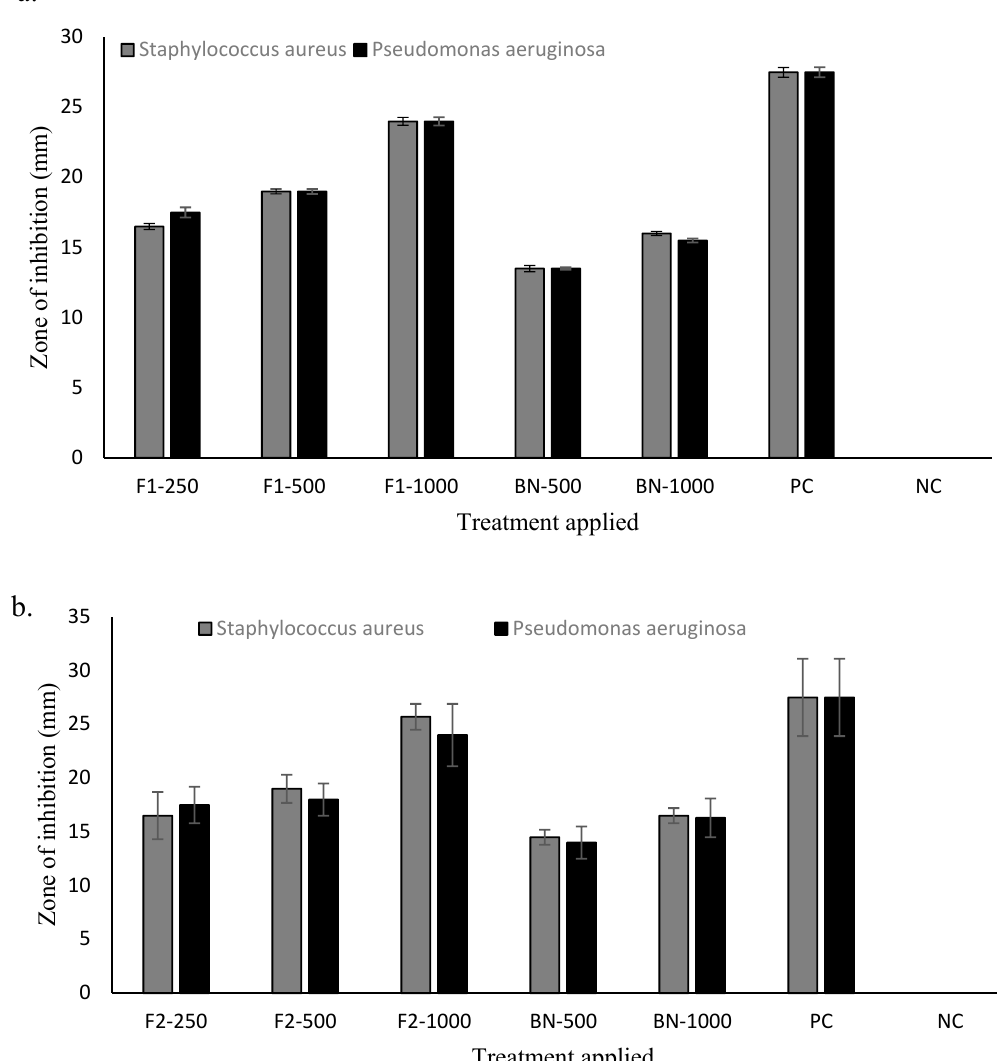
Figure 5. Antimicrobial activities of ( a ) F1 and ( b ) F2 different treatments applied: 250 µg, 500 µg, 1000 µg, BN = Blank nanoparticles, PC = positive control (Gentamicin), NC = negative control (distilled water).